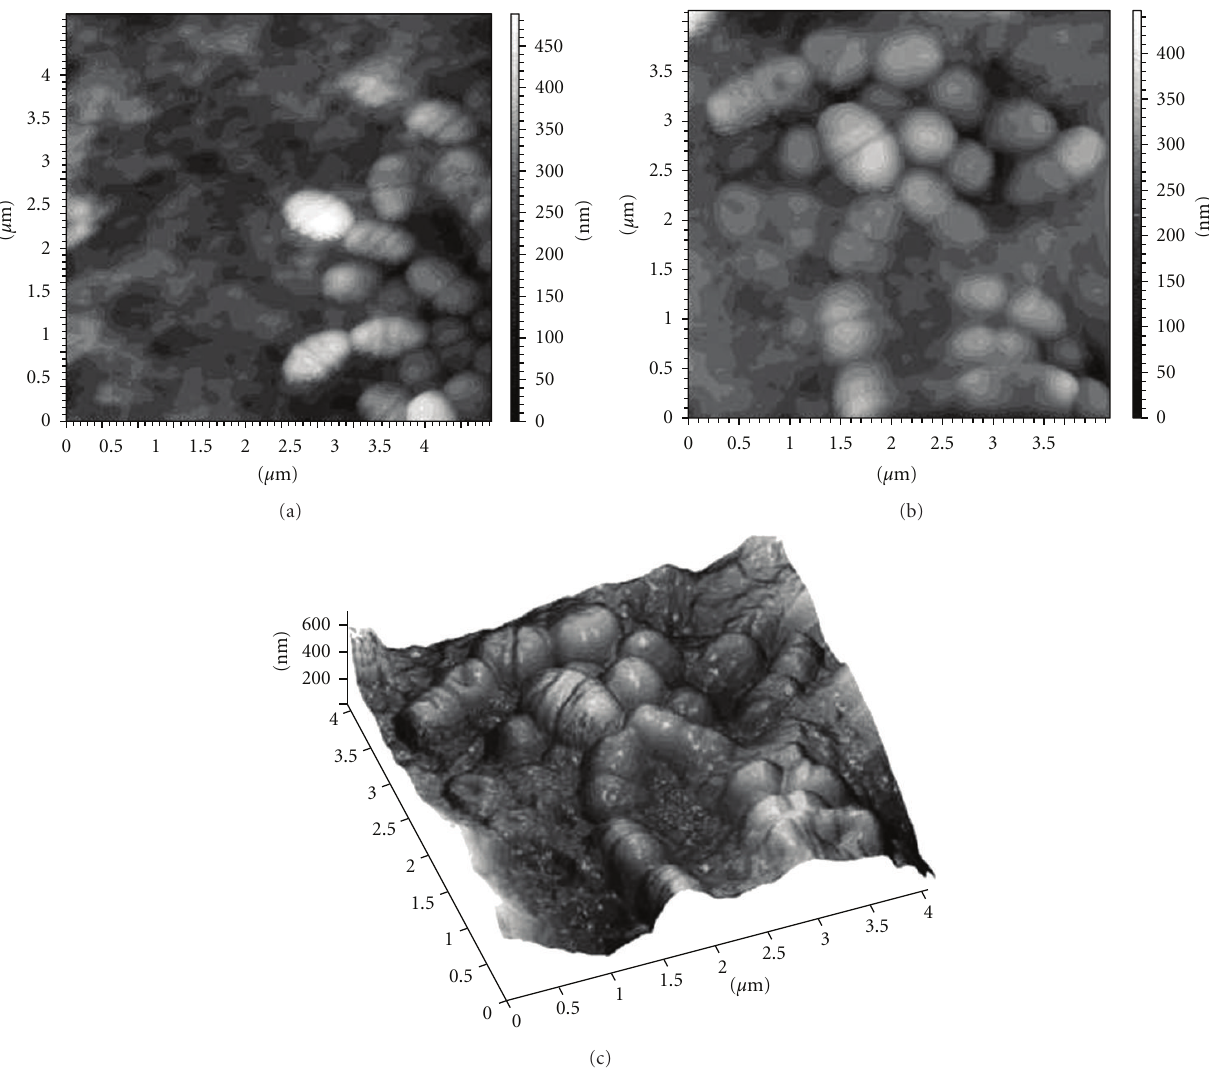
Figure 4: Atomic force microscopy images of Streptococcus mutans ATCC 25175 T colonizing single wall carbon nano tube-coated glass bead (SWCNT-GB). (a) SWCNT-GB colonization by Streptococcus mutans ATCC 25175 T after three hours of incubation (adherent S. mutans ); (b) SWCNT-GB colonization by S. mutans ATCC 25175 T after 24 hours of incubation ( S. mutans biofilm); (c) three-dimensional view of the same area of